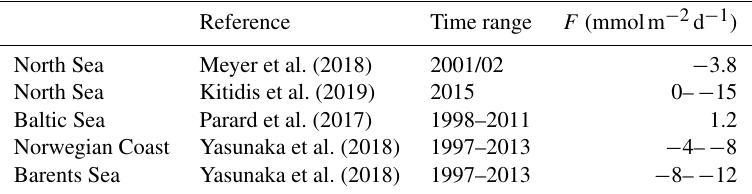
Table 2. Overview of air–sea CO 2 fluxes reported in the literature. Negative sign denotes flux from atmosphere to